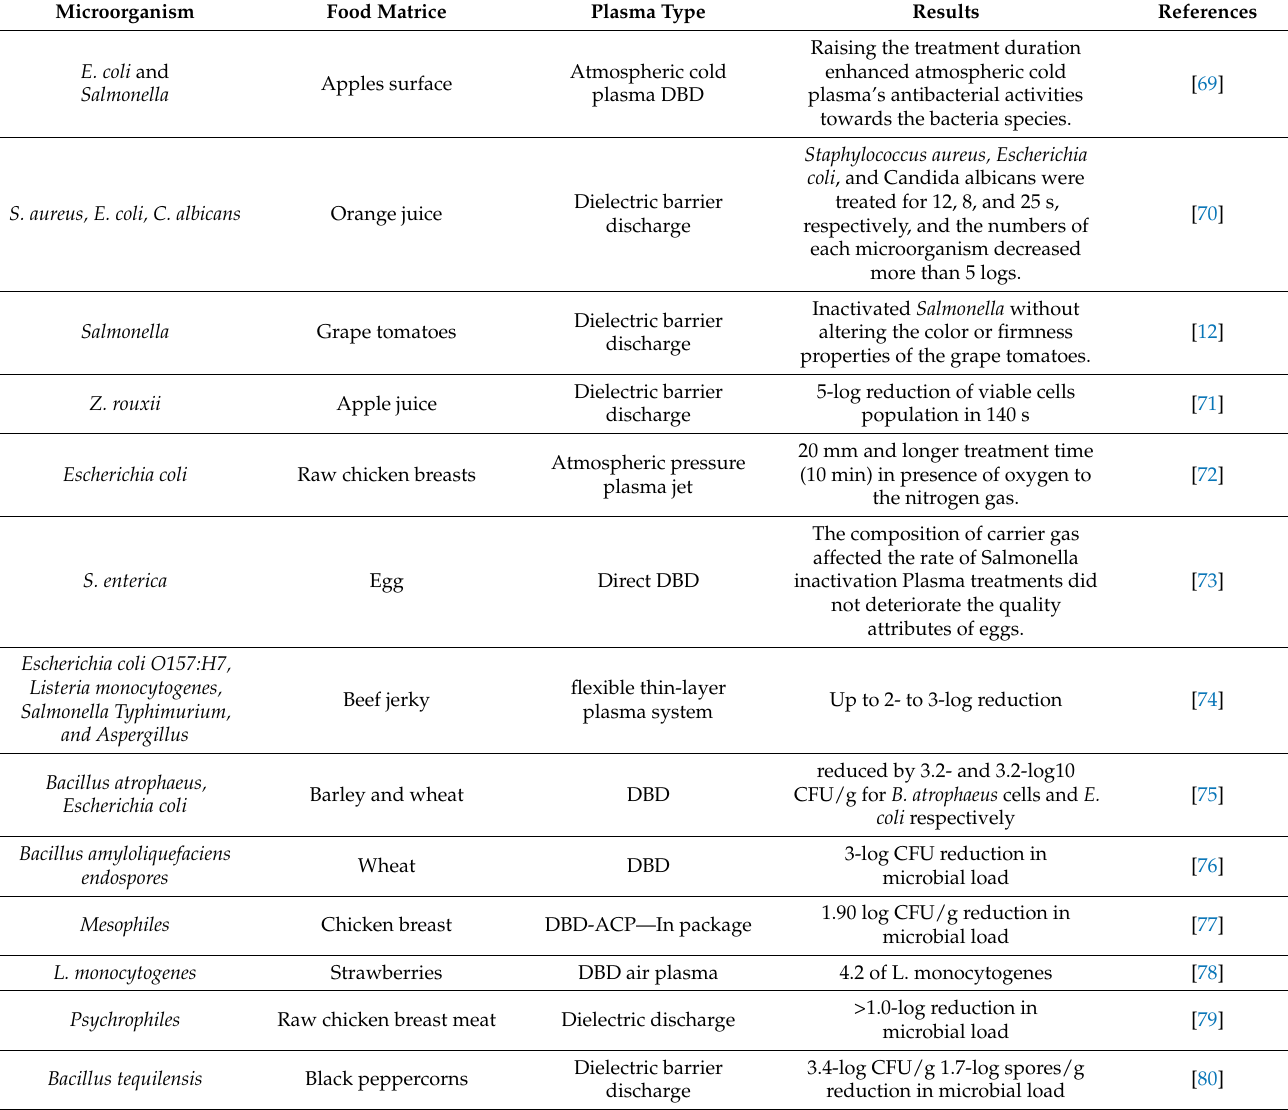
Table 3. Studies demonstrating decontamination using cold